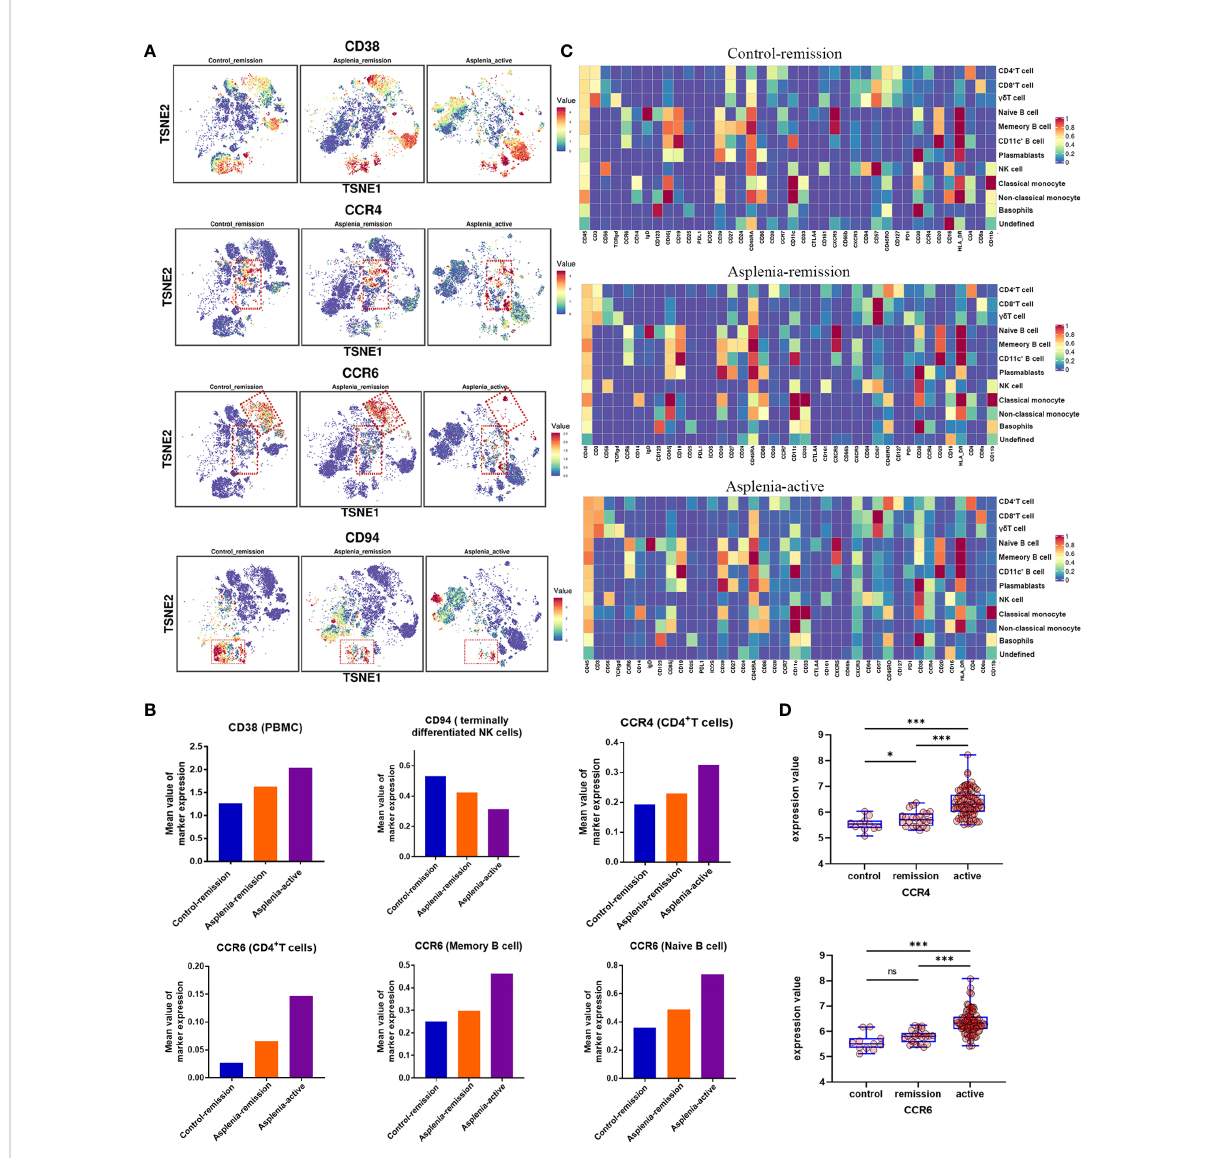
FIGURE 3 High-dimensional analysis revealing the differences in the expression of speci fi c surface markers on PBMC samples from the control patient and congenitally asplenic patient with remission CD, as well as the congenitally asplenic patient in the active stage of CD. (A) The t-distributed stochastic neighbor embedding plots colored by expression of CD38, CCR4, CCR6 and CD94 of each group. (B) The histograms displaying differences in the expression of surface markers (CD38, CCR4, CCR6 and CD94) across patient samples. (C) Heatmap representing the marker expression pro fi les of the 12 cell populations in PBMC. The heatmap colors represent the average expression of a given marker for each cell population. (D) Boxplot showing the difference in the expression of CCR4 (top) and CCR6 (bottom) in colon tissues from healthy controls, remission IBD and active IBD patients, with differences assessed by the GEO2R bioinformatics tool. (Raw data from GEO database, GSE59071; ns, not signi fi cant; *P<0.05;